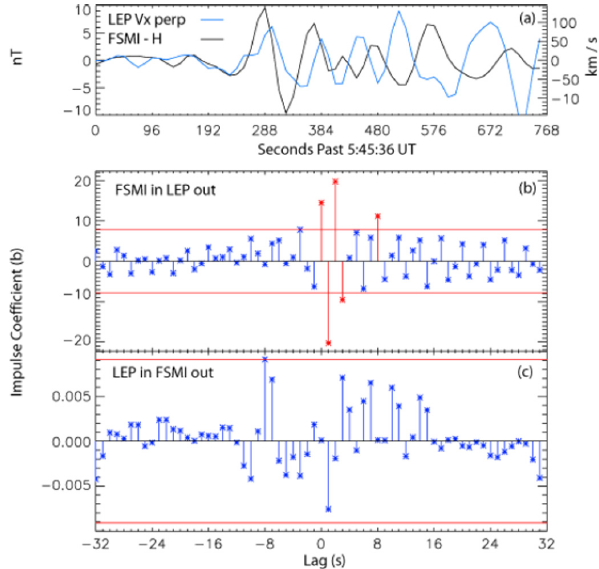
Fig. 7. Panel (a) , shows time-series of the Pi2 observed at FSMI (black) in nT (left axis), and of the BBF (blue) in kms − 1 (right axis). These are the data sets utilised in the impulse response func- tion. Panels (b) and (c) depict the results from the impulse response function, (b) BBF v ⊥ x as a function of the Pi2 waveform at FSMI and (c) the Pi2 waveform at FSMI as a function the BBF v ⊥ x . The y-axis is the value of the filter coefficient, β , as a function of the lag, s, on the x-axis. The horizontal lines represent the threshold defined in Eq. (2) and the red vertical lines represent the β coefficients lying above the